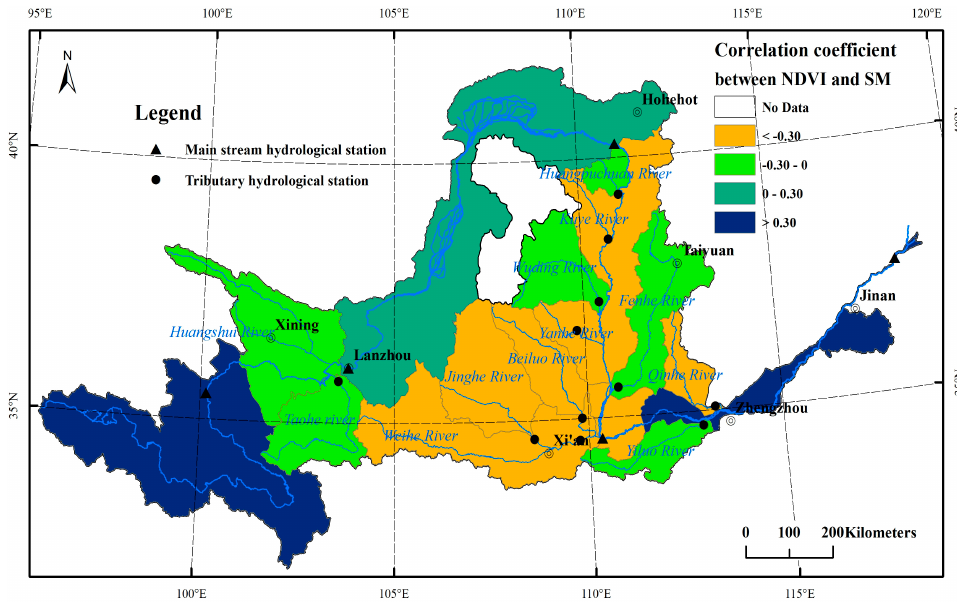
Figure 12. Correlation coefficients between NDVI and the sediment concentration in the Yellow River basin.